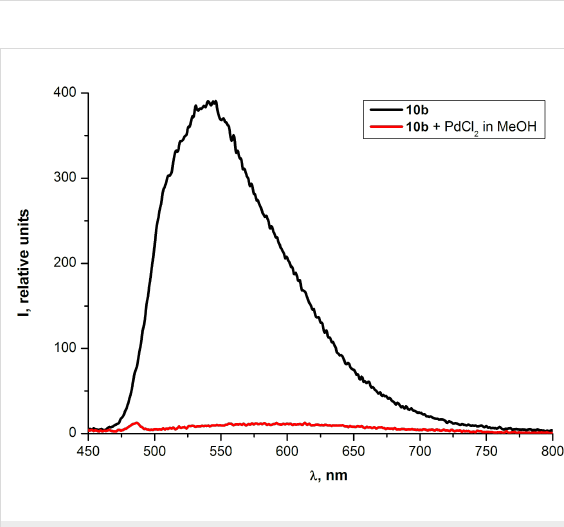
Figure 12: Optical absorption spectra of PAE 10a in THF before and after the addition of HCl (10 equiv).